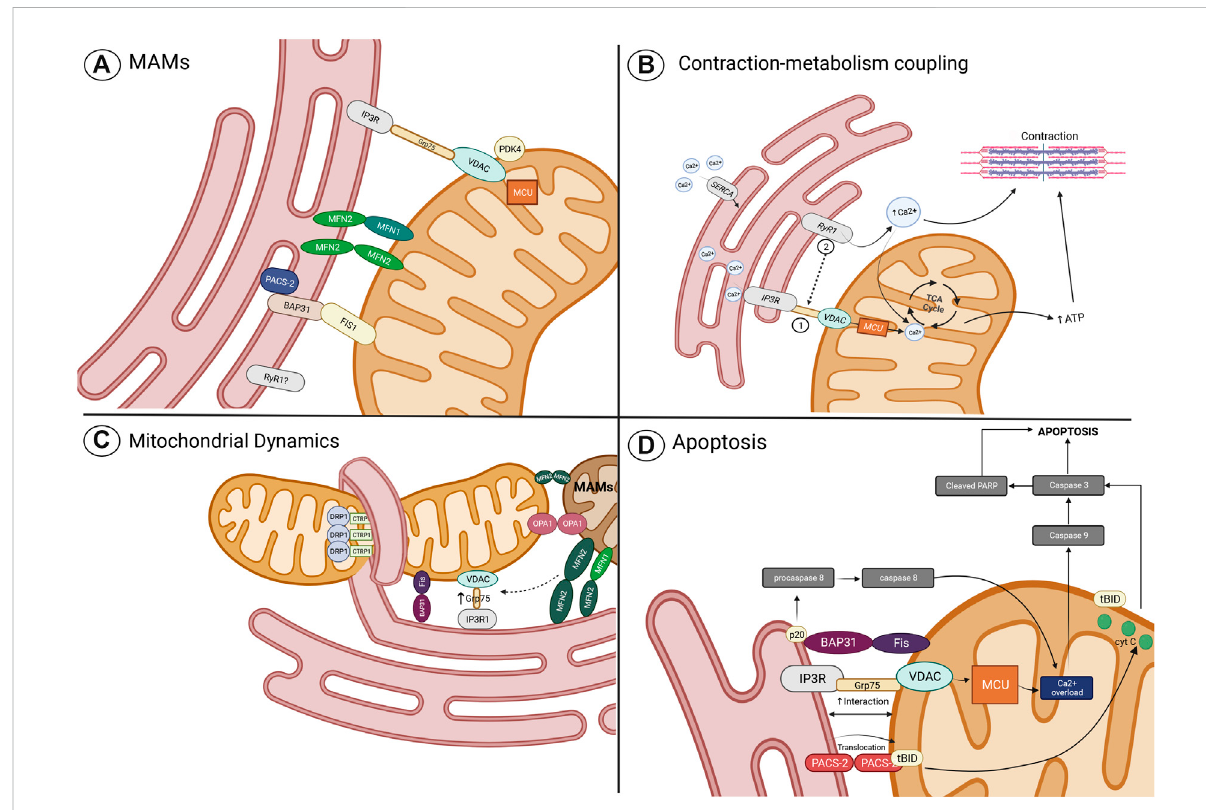
Role ofMAMs in theregulation of cellular processes. (A) Main MAM proteinsidenti fi edin skeletal muscle; (B) Contraction-metabolism coupling mediated by the transport of Ca 2+ from SR/ER to mitochondria through the MAM complex, the IPR3-GRP75-VDAC-MCU, which function can be altered by the proposed mechanisms of ER stress and mitochondrial dysfunction; (C) role of proteins related to mitochondrial dynamics in the tethering of mitochondria and ER (or SR to skeletal muscle), calcium transfer, and mitochondrial fi ssion and fusion regulation; and (D) MAMs proteins related to the apoptosis pathway. Imagen created with